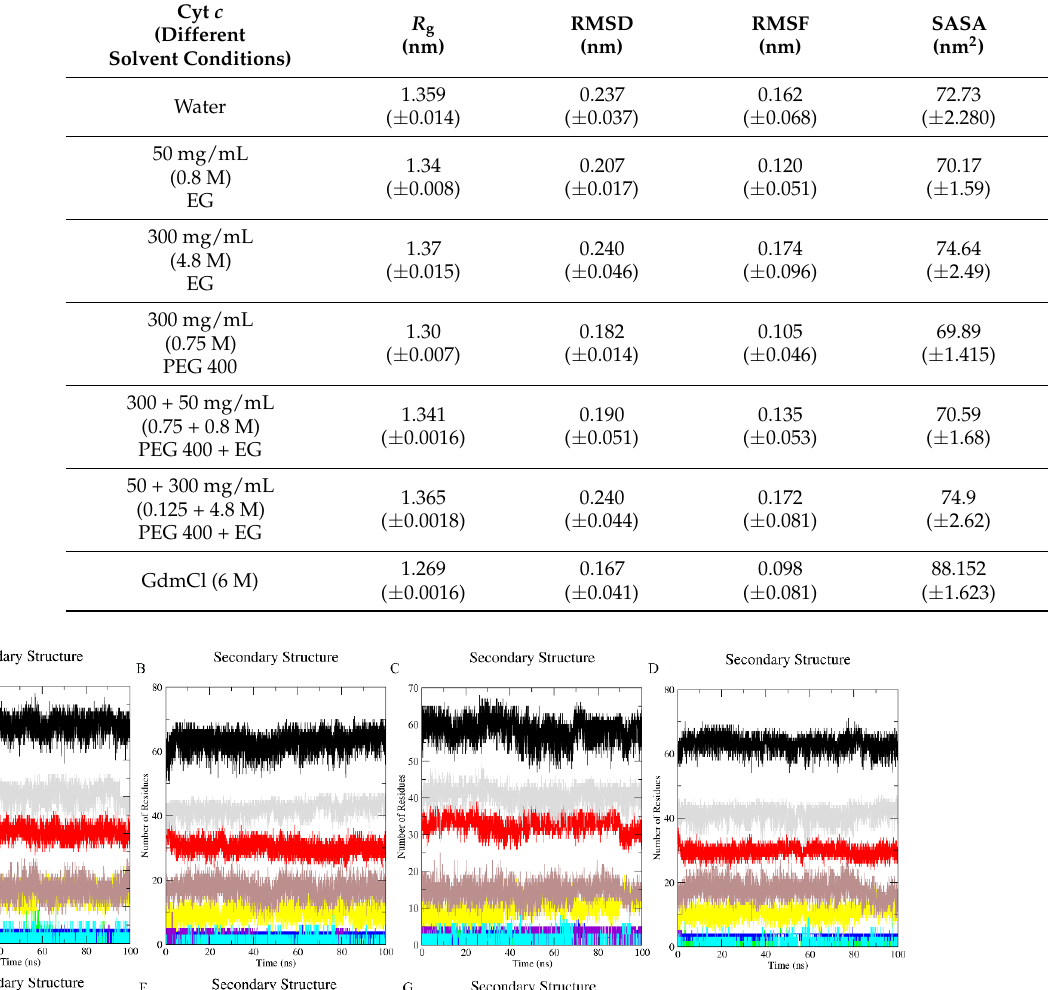
Table 2. Average values of R g , RMSD, RMSF, and SASA obtained from MD simulations of cyt c in different solvent conditions.